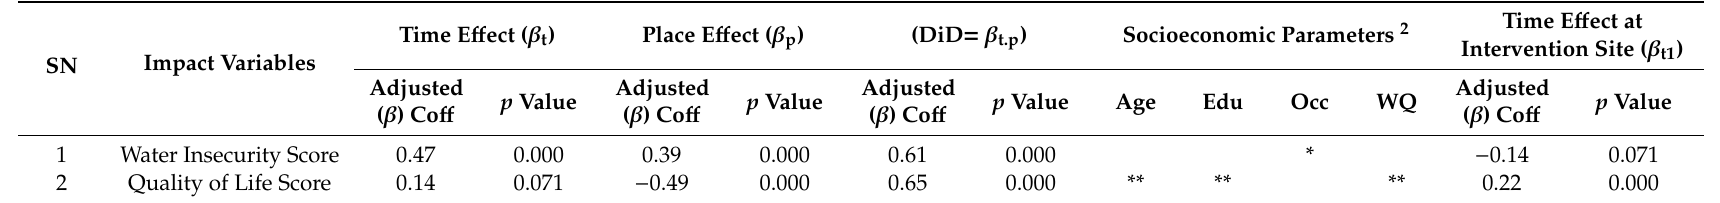
Table 5. Statistical evaluation of the impact of LCD-treated water distribution on continuous impact variables 1